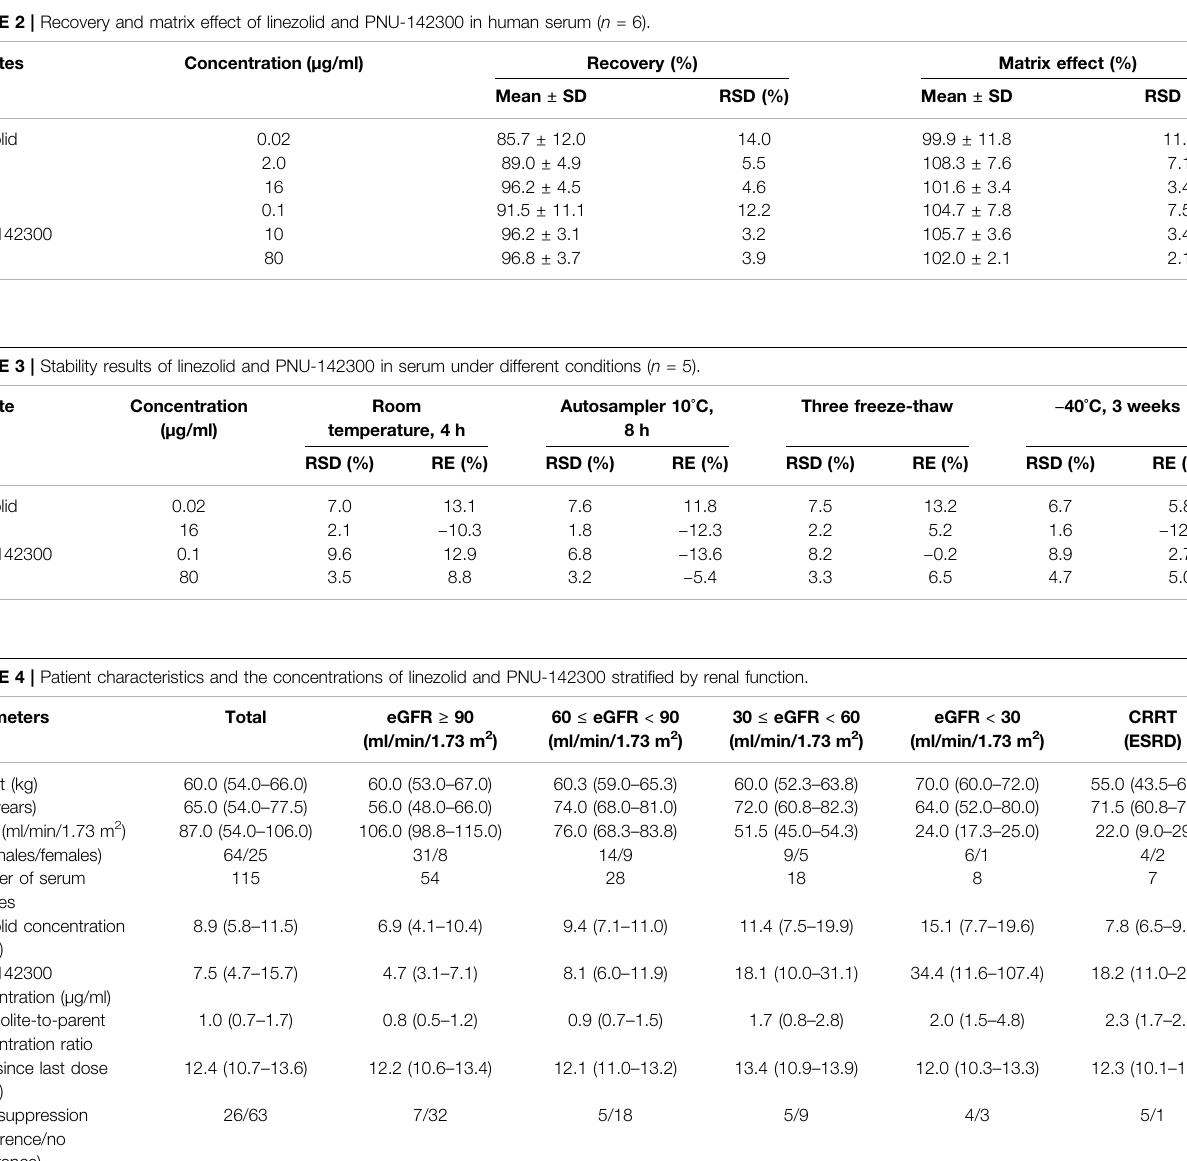
TABLE 2 | Recovery and matrix effect of linezolid and PNU-142300 in human serum ( n (cid:2) 6). Analytes